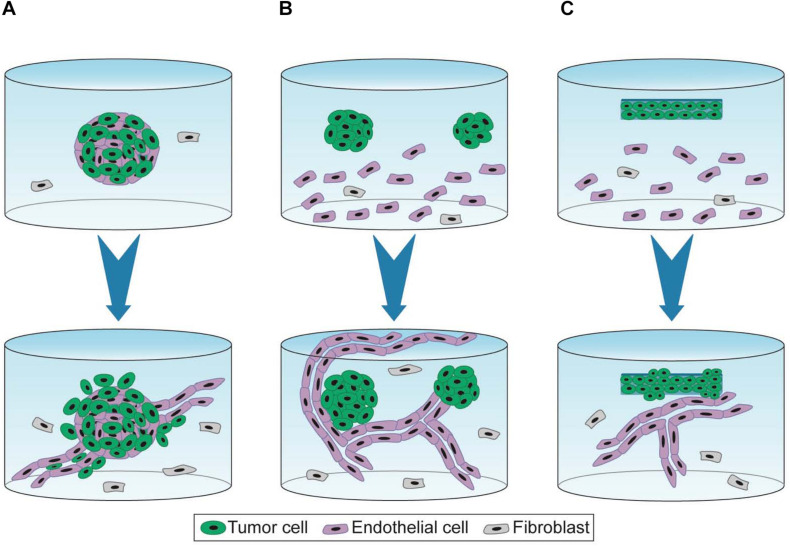
3D experimental settings of capillary formation and tumor growth. 3D cell co-culture is performed for 7 days (A), 7–10 days (B), and 10–21 days (C) (blue arrow). (A) Spheroids containing tumor and endothelial cells are embedded in fibrin hydrogel containing fibroblasts in suspensions. Capillaries are formed by a sprouting angiogenesis-mimicking process and grow away from the tumor mass (Ehsan et al., 2014). (B) Spheroid cells are embedded in functionalized PEG-derived hydrogel containing EC and fibroblasts in suspension. Capillaries formed by vasculogenesis, unfold the tumor mass but barely vascularize it (Bray et al., 2015; Taubenberger et al., 2016). (C) Dense artificial cancer mass (ACM) is obtained by plastic compression of collagen hydrogel containing tumor cells. ACM is then embedded in collagen hydrogel containing EC and fibroblasts in suspension. This setting is further compressed. Capillaries are formed by vasculogenesis (Magdeldin et al., 2017; Pape et al., 2019).